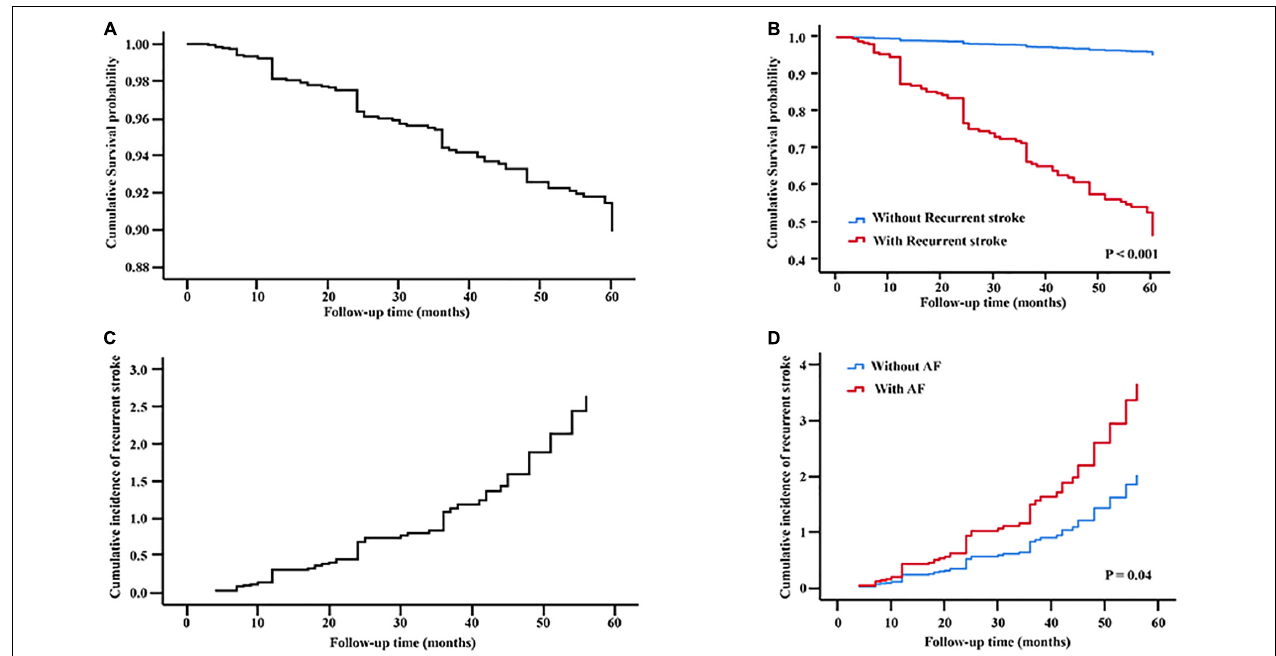
FIGURE 4 | Multivariate Cox regression analysis. Cumulative survival probability were plotted according to (A) all patients and recurrent stroke presence (B) in all patients. Cumulative incidence curves of recurrence stroke were plotted according to (C) all patients and AF presence (D) in all patients. AF, atrial fibrillation.